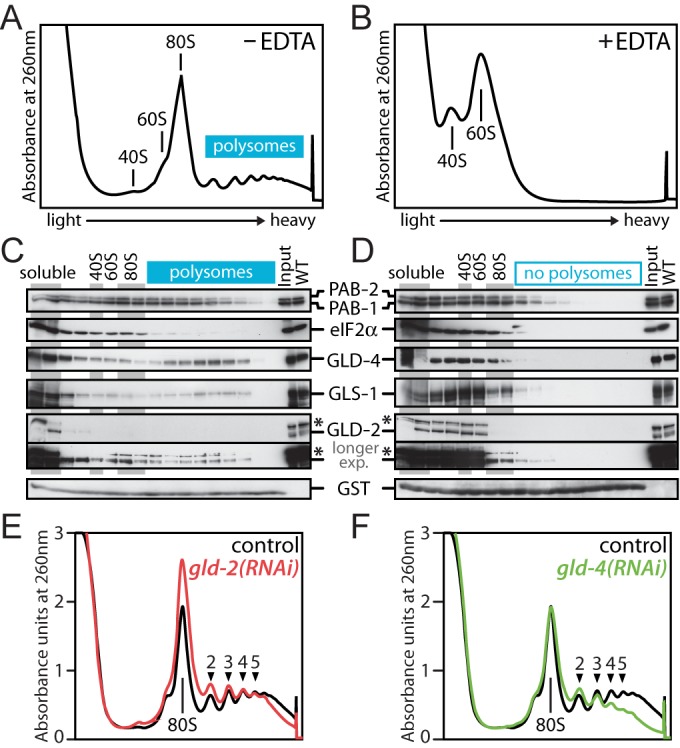
GLD-4 co-sediments with polysomes and promotes polysome formation. (A and B) Typical absorbance profiles of a wild-type polysome gradient (A) without or (B) with prior EDTA treatment (n = 3). The positions of major ribonucleoprotein complexes are indicated. (C and D) Western blot analysis of fractionated material from (A) and (B). Equal exposure times for each antibody in (C) and (D); for GLD-2, also a longer exposure of the same blot is shown; asterisk marks an unspecific background band. (E and F) Representative absorbance profiles from extracts of RNAi-treated animals (n > 4). The numbers indicate the position of polyribosome peaks that are clearly detected in the control RNAi sample.